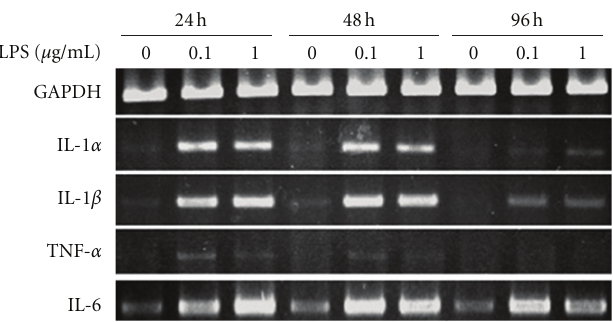
Figure 5: Expression of pro-inflammatory cytokine genes in human bone marrow cells. IL-1 α , IL-1 β , TNF- α , IL-6, and GAPDH gene expression in hBMCs cultures with or without LPS stimulation. LPS concentrations were 0 μ g/mL, 0.1 μ g/mL or 1 μ g/mL. RNA was isolated at 24, 48, and 96 hours. RT-PCR was carried out at 30 cycles for GAPDH, IL-1 α , IL-1 β , and TNF- α , and 25 cycles for IL-6.